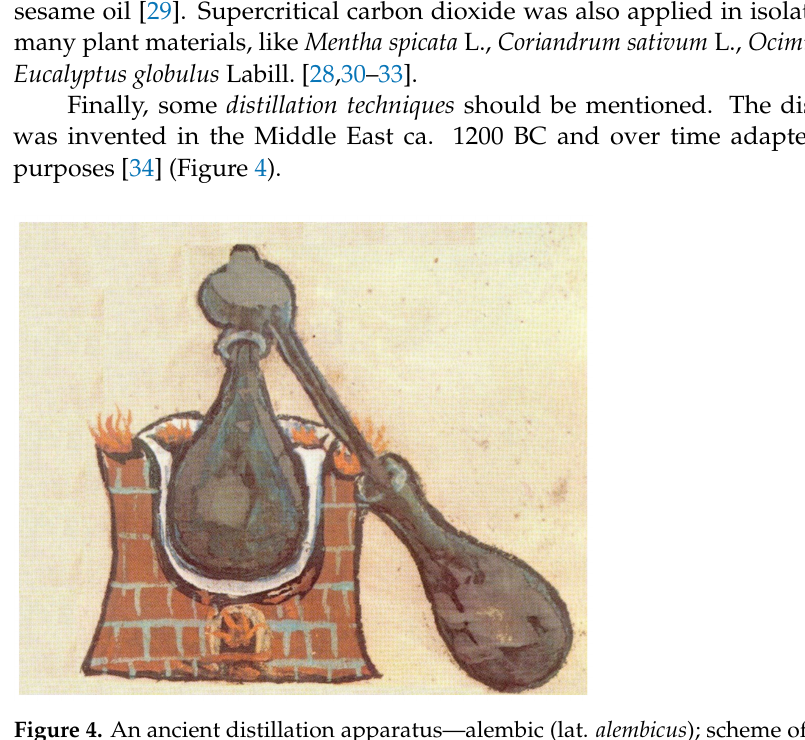
Figure 4. An ancient distillation apparatus—alembic (lat. alembicus ); scheme of an alembic from a medieval manuscript [35]